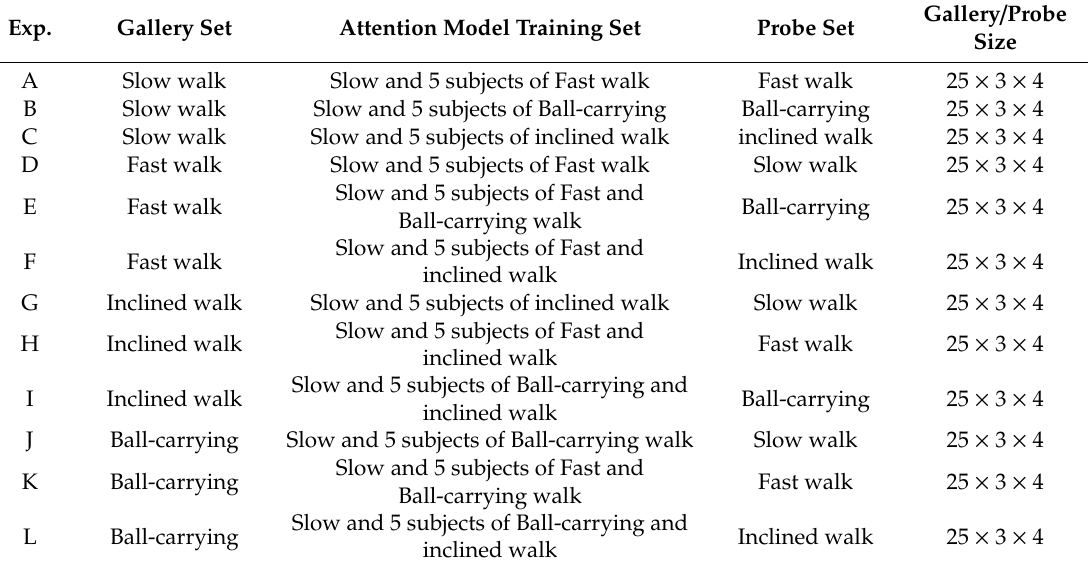
Table 1. Twelve experiments on CMU MoBo gait dataset (in lateral view).